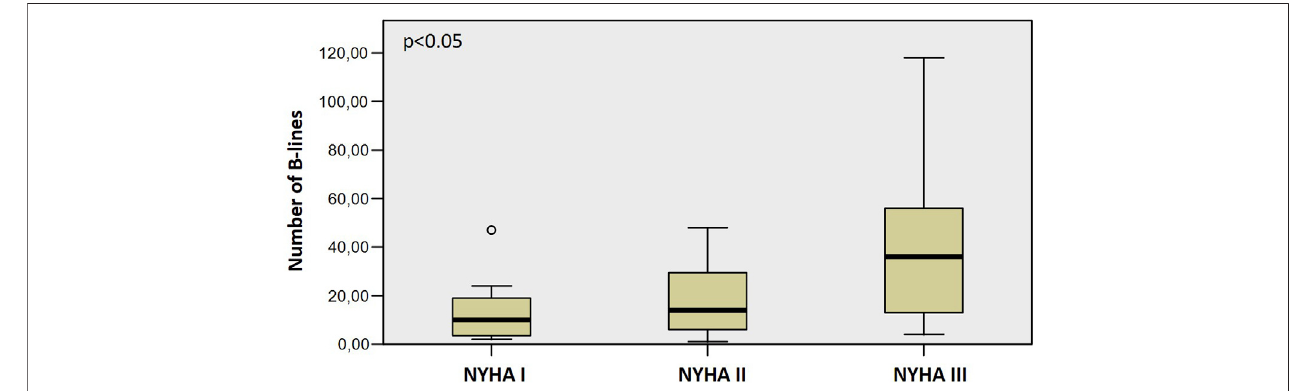
FIGURE 1 | The increasing number of B-lines with worsening NYHA functional class.